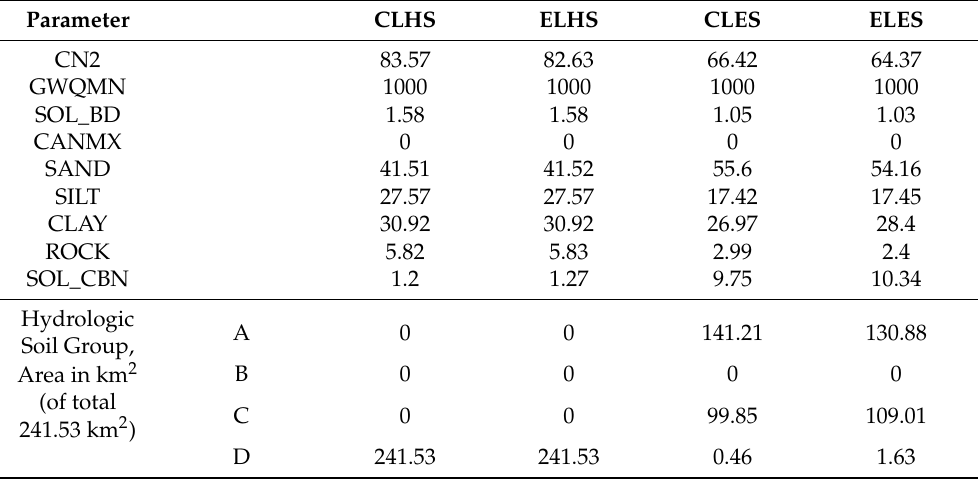
Table 5. Original values of parameters at model creation, area and depth-weighted catchment sum- mary and additional explanatory variables (SAND, SILT, CLAY, ROCK, SOL_CBN, and Hydrologic Soil